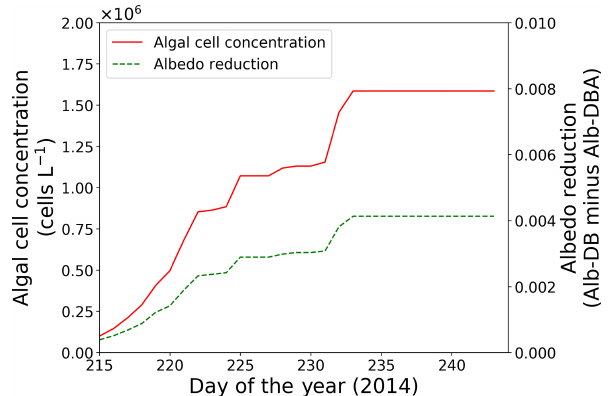
Figure 5. Temporal changes in algal cell concentration and albedo reduction from days 215 to 243 at the study site; algal cell concen- tration (red solid line) and albedo reduction (green dotted